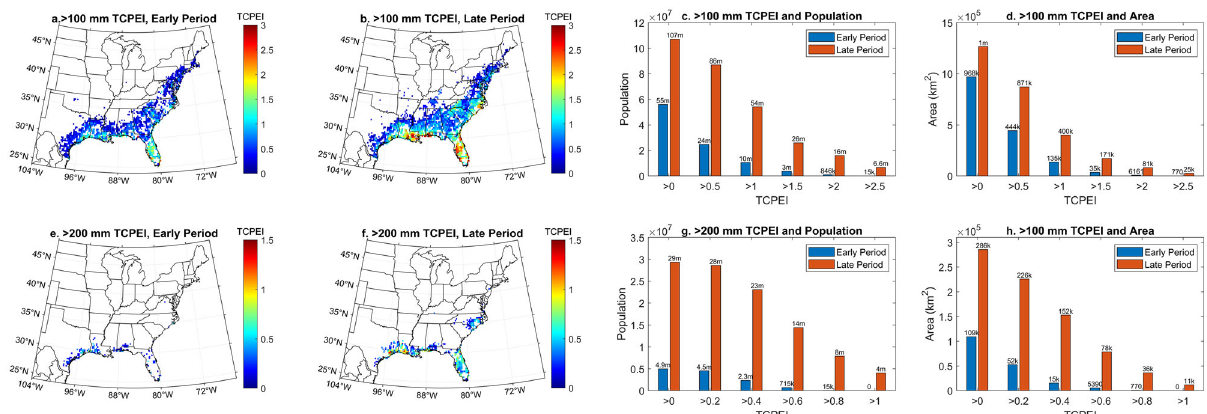
Fig. 4 Spatial Changes in the population-based Tropical Cyclone Precipitation Exposure Index (TCPEI), comparison of population and area for different ranges of TCPEI, relative changes in TCP probabilities, and relative changes in population and Gross Domestic Product (GDP). Each panel represents: a >100 mm daily TCPEI in the early period, b >100 mm daily TCPEI in the late period, c population comparison between the early period and the late period for different ranges of >100 mm daily TCPEI, d comparison of the impacted area between the early period and the late period for different ranges of >100 mm daily TCPEI, e >200 mm daily TCPEI in the early period, f >200 mm daily TCPEI in the late period, g population comparison between the early period and the late period for different ranges of >200 mm daily TCPEI, h the comparison of the impacted area between the early period and the late period for different ranges >200 mm daily TCPEI, i relative changes in >100 mm daily TCP probability, j relative changes in >200 mm daily TCP probability, k relative changes in the logarithm of the population, l relative changes in the logarithm of GDP. The 1970 Population and the 1949 – 1998 TCP are used to calculate the early period TCPEI. The 2020 population and 1969 – 2018 TCP are used to calculate the late period TCPEI. In panels c , d , g , h , “ m ” stands for million and “ k ” stands for